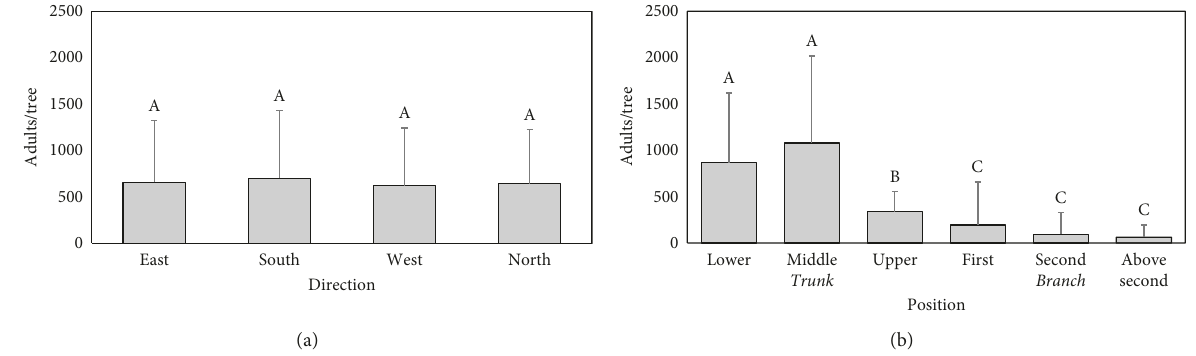
Figure 3: Lycorma delicatula adult count (mean ± SD) by (a) direction and (b) within-tree position. Means followed by the same uppercase letter are not significantly different ( α � 0.05).